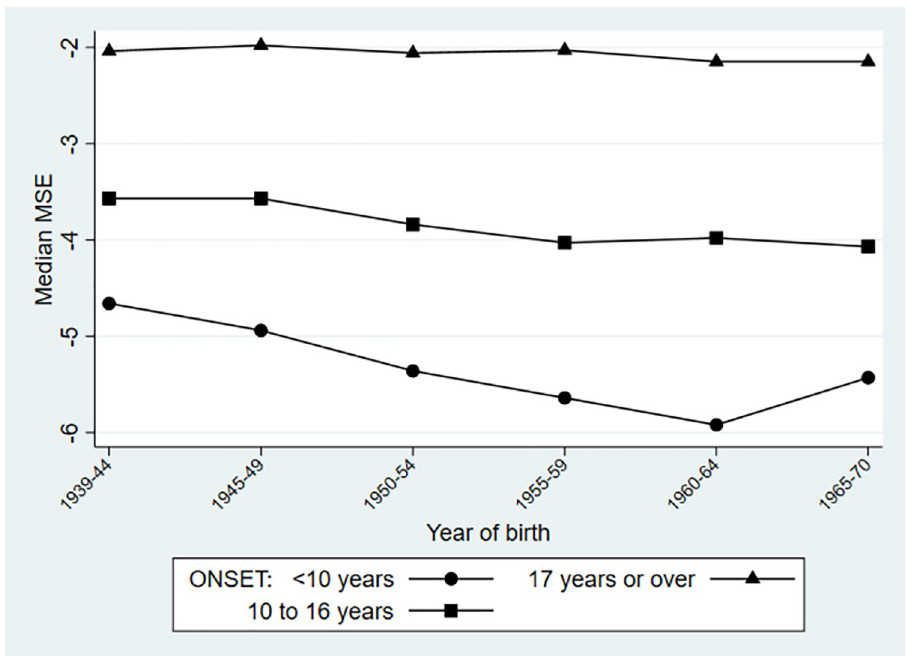
Fig 2. Median MSE (mean spherical equivalent): Childhood-onset myopia (subdivided: Before age 10 and aged 10 to 16 years) and adult-onset myopia, by year of birth as 5-year bands.